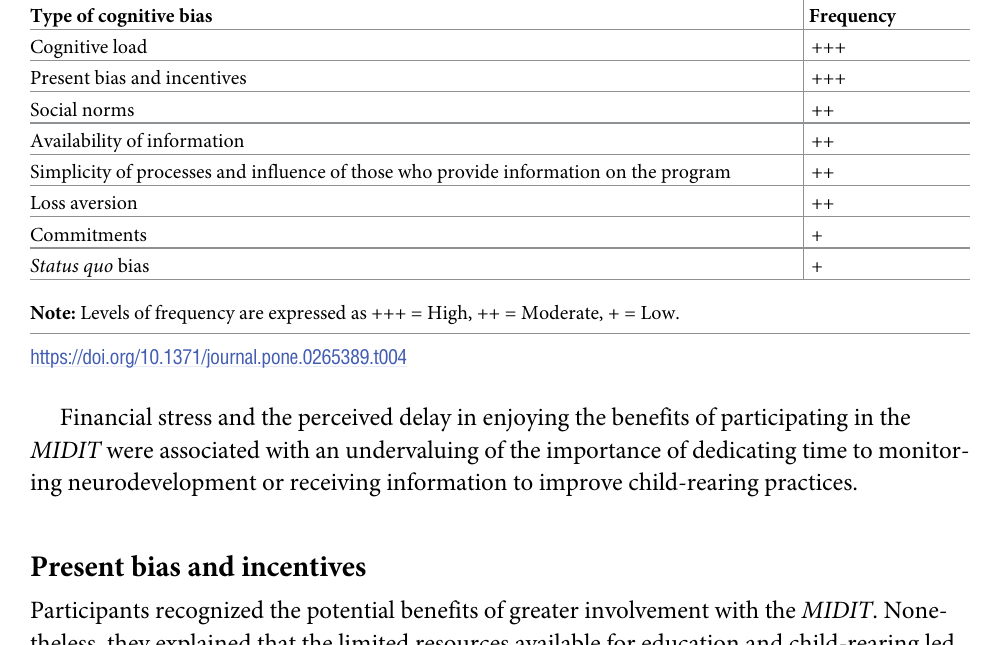
Table 4. Cognitive biases identified by level of intensity. Oaxaca, Me´xico, 2019.